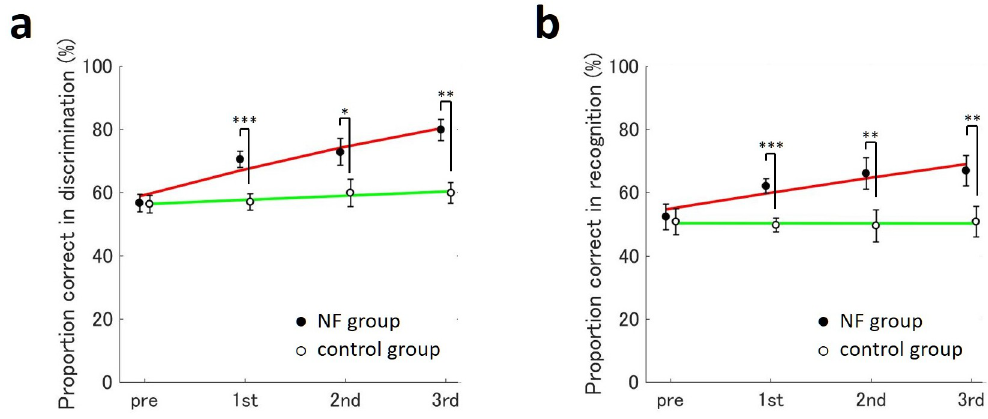
Fig 4. Performance in the behavioral auditory tests; (a) average proportion of correct responses and logit models for pre- and post-test data from the NF group (green line) and control group (red line) in the discrimination and (b) recognition task on each training day for the three pairs of words. Error bars represent the standard error of the mean (SEM); � p < 0.05, �� p < 0.01, ��� p < 0.001.